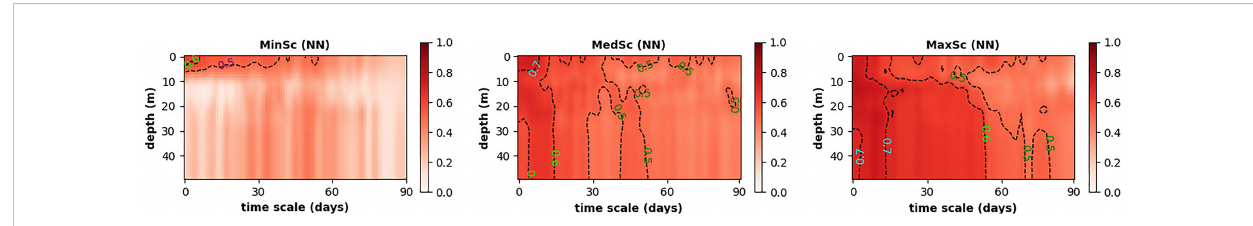
FIGURE 11 The dependence of the MLP NN model (Pearson correlation) skill across the full range of L4 depths (y-axis) on the time-resolution of the data (the time-scale of the low-pass fi lter, x-axis). Similarly to Figure 9, the different panels show the different scenarios explored